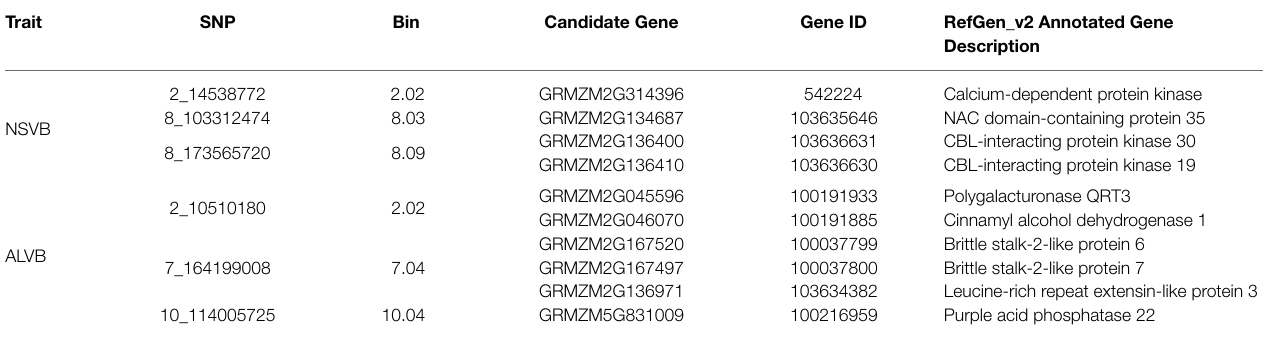
TABLE 5 | Potential candidate genes for vascular bundle-related